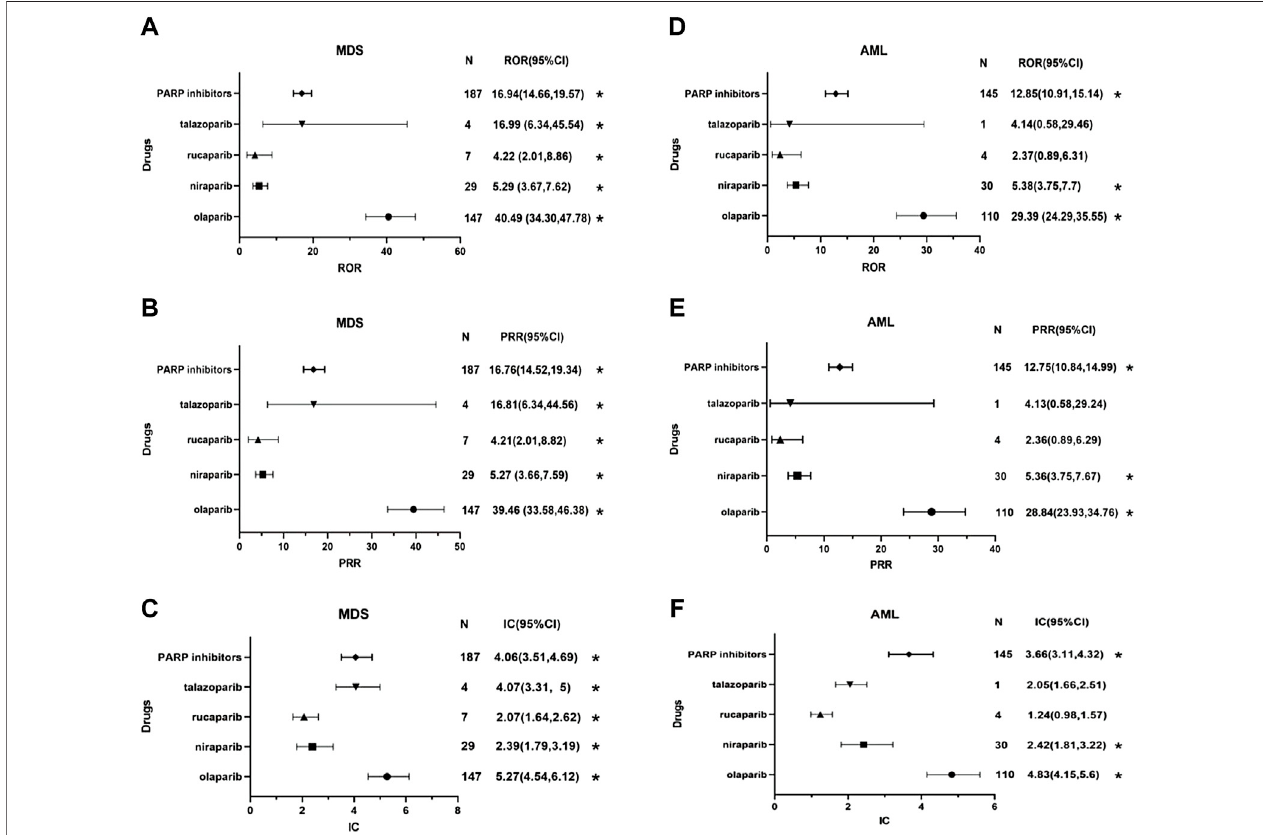
FIGURE 2 | Forest plots of disproportionality analysis of MDS/AML associated with PARP inhibitors. * Statistically signi fi cant disproportionality (the standard of signal detection in the Supplementary Table S2 ). Abbreviation: MDS, myelodysplastic syndrome; AML, acute myeloid leukemia; N, the number of reports of PARP- associated myelodysplastic syndrome or acute myeloid leukemia; CI, con fi dence interval; ROR, reporting odds ratio; PRR, proportional reporting ratio; IC, information component; PARP inhibitors, poly (ADP-ribose) polymerase inhibitors. (A) the reporting odds ratio (ROR) distribution of MDS reported by PARP inhibitors. (B) the proportional reporting ratio (PRR) distribution of MDS reported by PARP inhibitors. (C) the information component (IC) distribution of MDS reported by PARP inhibitors. (D) the reporting odds ratio (ROR) distribution of AML reported by PARP inhibitors. (E) the proportional reporting ratio (PRR) distribution of AML reported by PARP inhibitors. (F) the information component (IC) distribution of AML reported by PARP